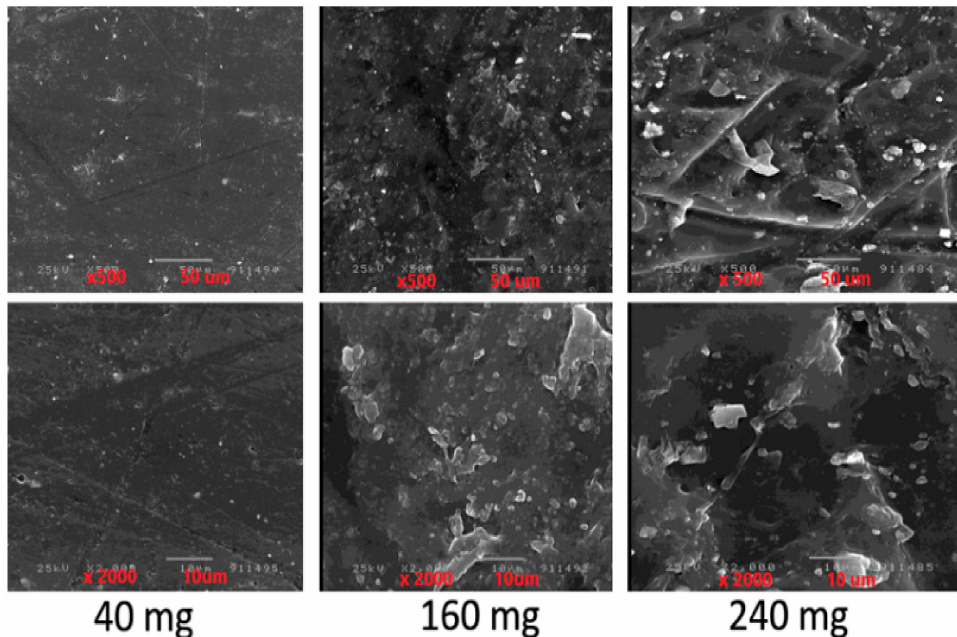
Figure 2. Electron scanning microscope image of selected prepared bioadhesive